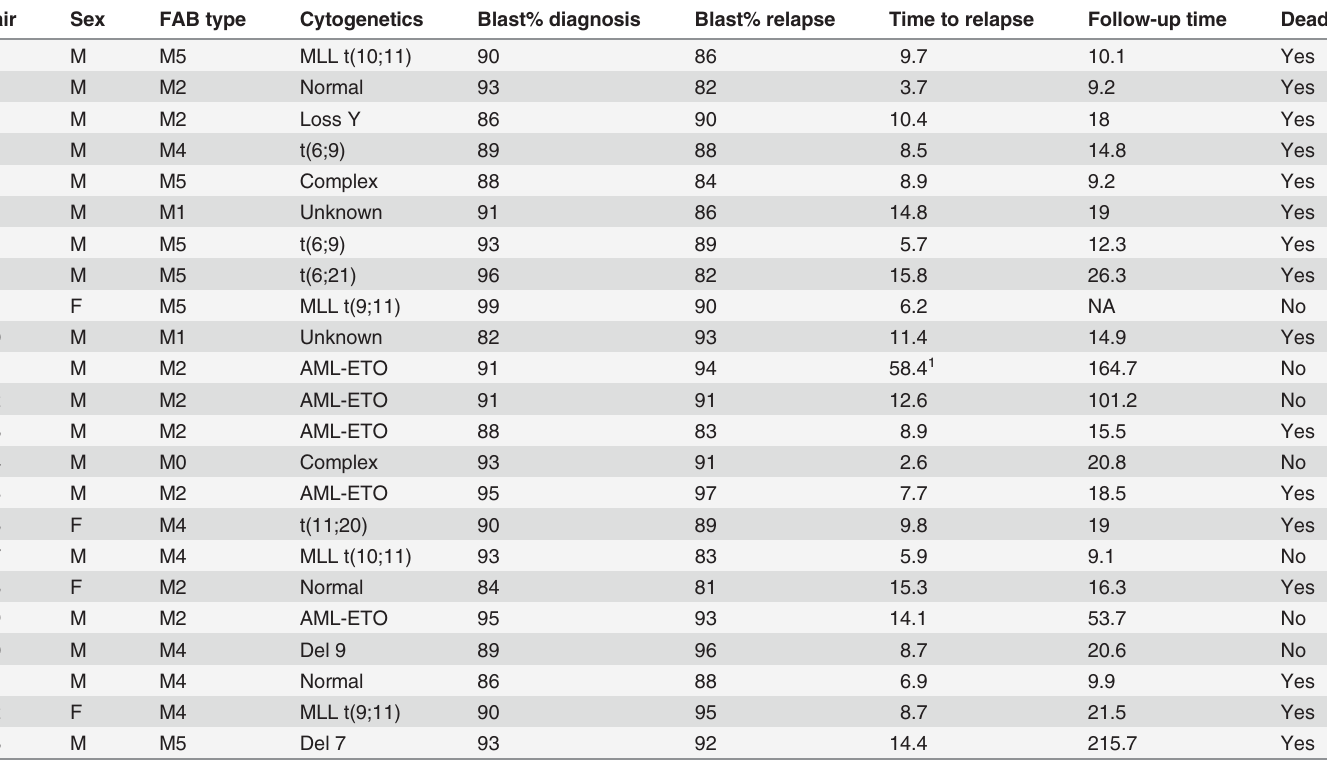
Table 1. Clinical characteristics of the 23 childhood AML patients in this study at presentation and first